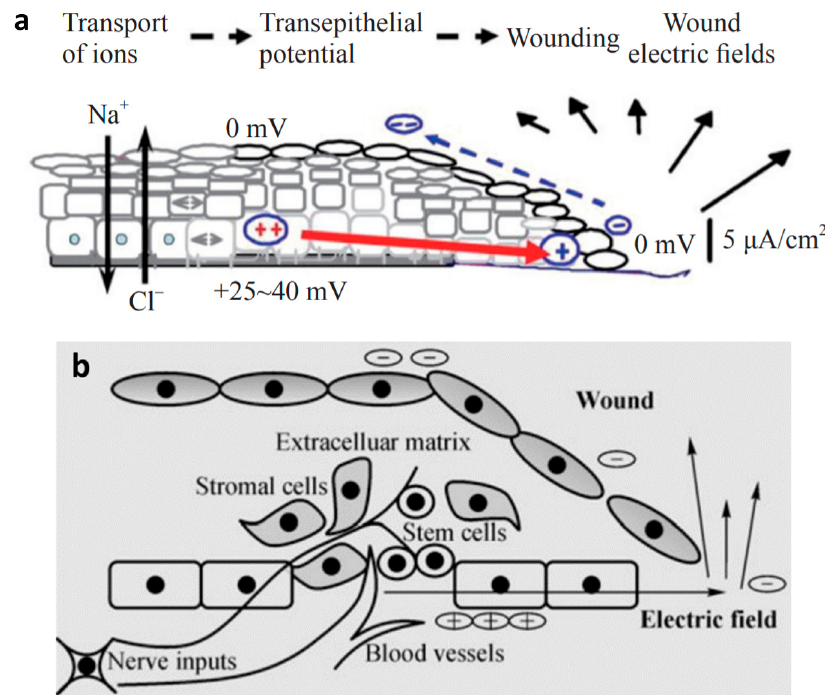
Figure 7. Schematic diagram of the electric field at a wound. ( a ) Na + /K + ATPase pumps transport ions through the epidermis of intact tissue, resulting in the skin battery. At a wound, the transepithelial potential is short-circuited, inducing a lateral electric field pointing toward the center of the wound. Adapted from [236], with permission from Elsevier. ( b ) The model proposed by Li and Jiang for a stem cell niche in a skin wound, composed of stem cells, stromal support cells, extracellular matrix proteins, blood vessels and neural inputs. According to the model, endogenous wound electric fields exert effects on the local stem cells for days until the wound heals. Reprinted by permission from Springer Nature: [237].